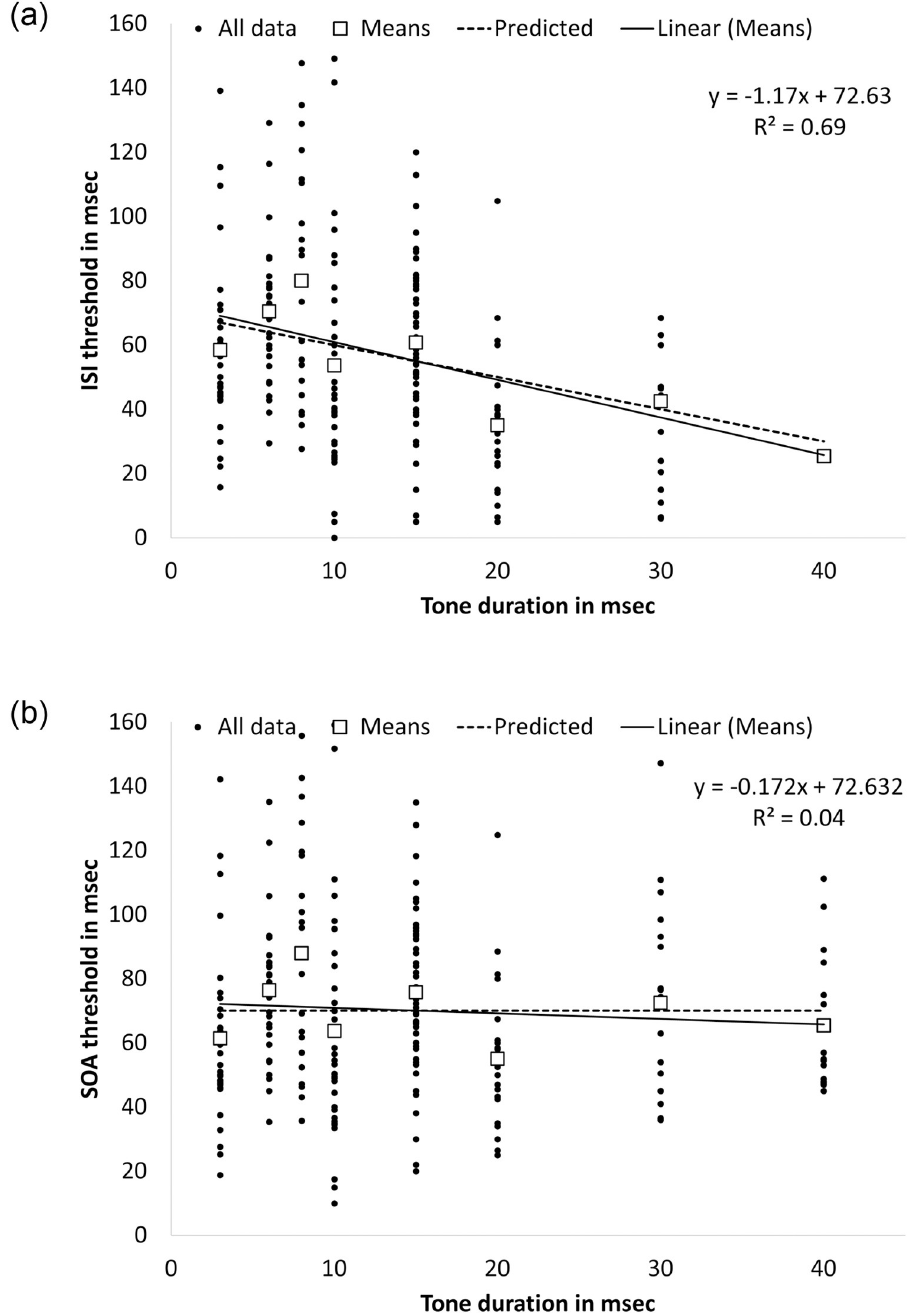
Fig 3. TOJ thresholds of young adult participants across eight different stimulus durations for: (a) ISI thresholds (silent gap between the offset of the stimulus at the leading ear and the onset of the stimulus at the lagging ear); and (b) SOA thresholds (duration of the stimulus at the leading ear added to the ISI threshold). a . ISI thresholds. b . SOA thresholds.